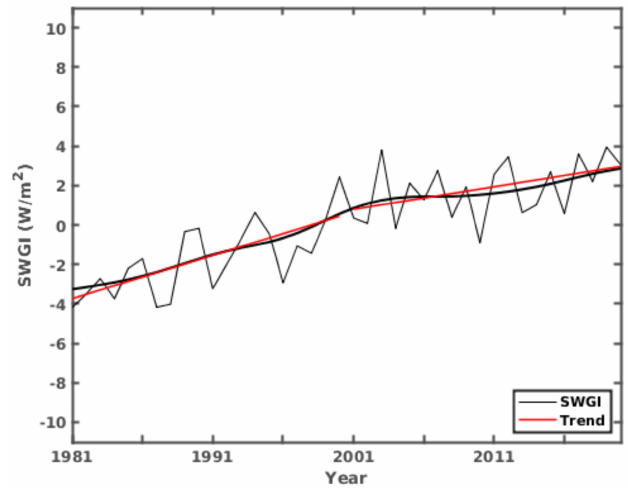
Figure 13. Temporal variation of the composite annual SWGI averaged in the Euro-Mediterranean area from ERA5-Land dataset for the 1981–2020 period (grey line) plotted together with a 5-year Gaussian low-pass filter (black thick line) and trend lines for the periods 1981–2000 and 2001–2020 (red lines). The SWGI series is expressed as anomalies from the 1981–2020 mean.